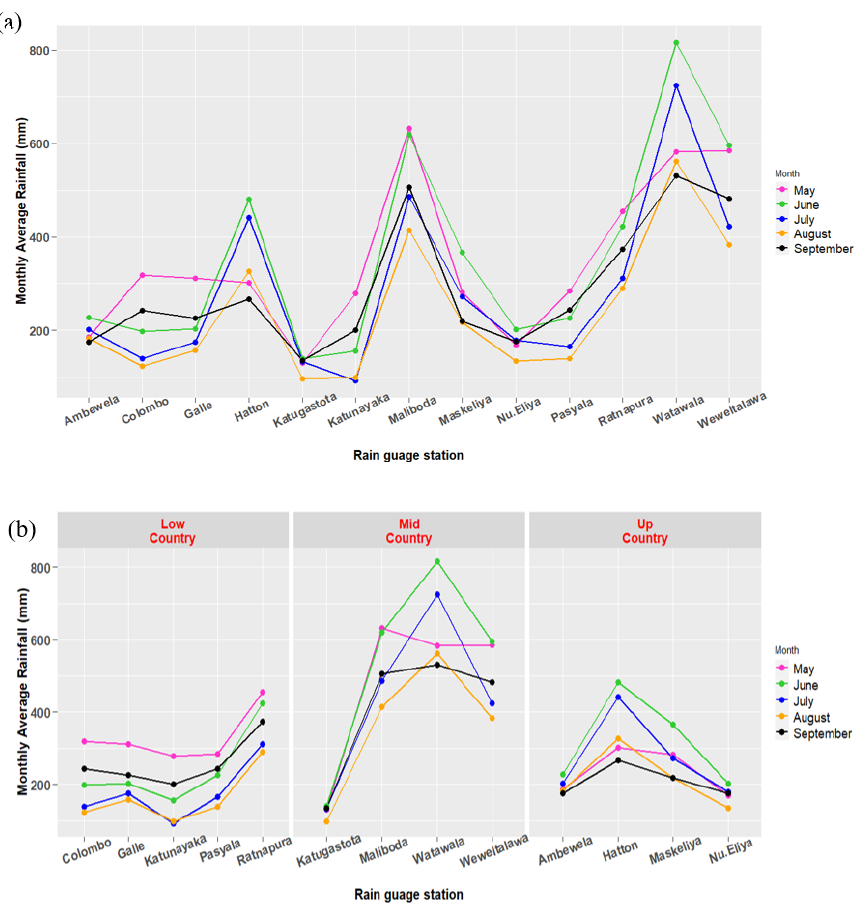
Figure 1: Monthly average rainfall for (a) 13 rain gauge stations (b) low, mid, and up country for 13 rain gauge stations during 1981 -